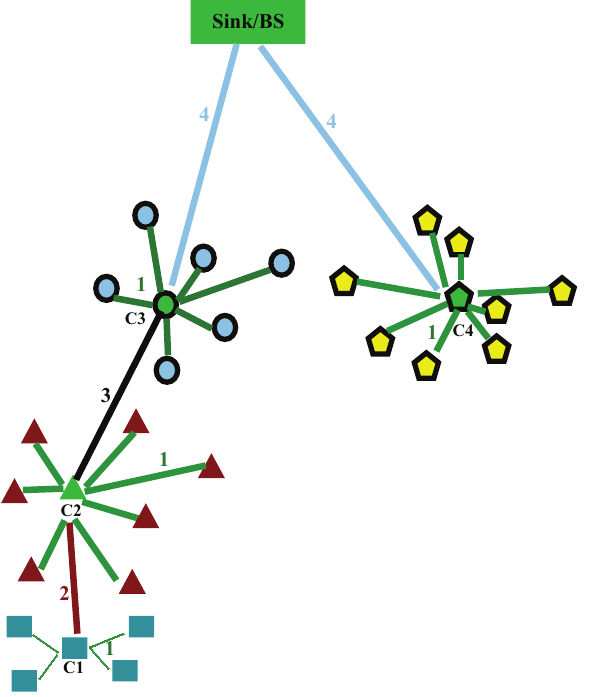
Figure 1. Communication model in